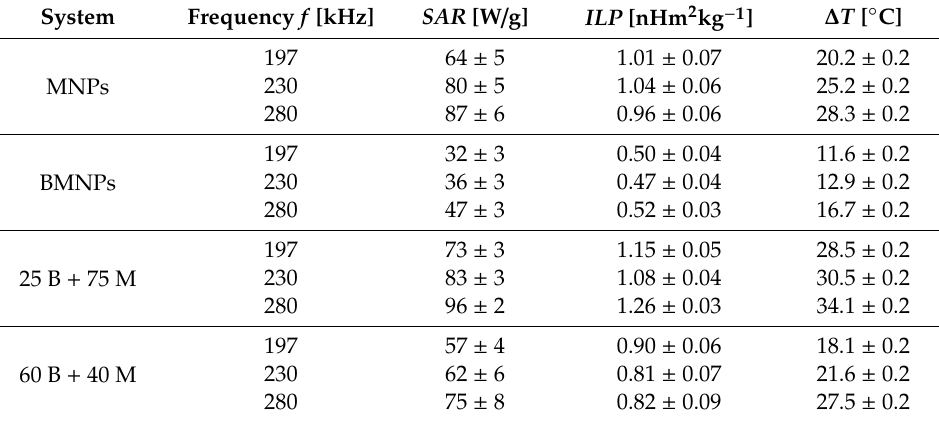
Figure 8. Frequency dependence of ( a ) SAR and ( b ) ILP , for the investigated systems. MNPs ( ■ ), BMNPs ( ● ), 60 B + 40 M ( ▲ ), and 25 B + 75 M ( ♦ ). Magnetic field strength: 18 kA/m; particle concentration: 25 mg/mL. Table 1. Summary of Specific Absorption Rate (SAR), Intrinsic Loss Power (ILP) calculations, and temperature increase after 60 s exposition time, Δ T , for the different samples tested [inorganic Magnetic Nanoparticles (MNPs) and MamC-medianted Biomimetic Magnetic Nanoparticles (BMNPs)] , and the field frequencies indicated.